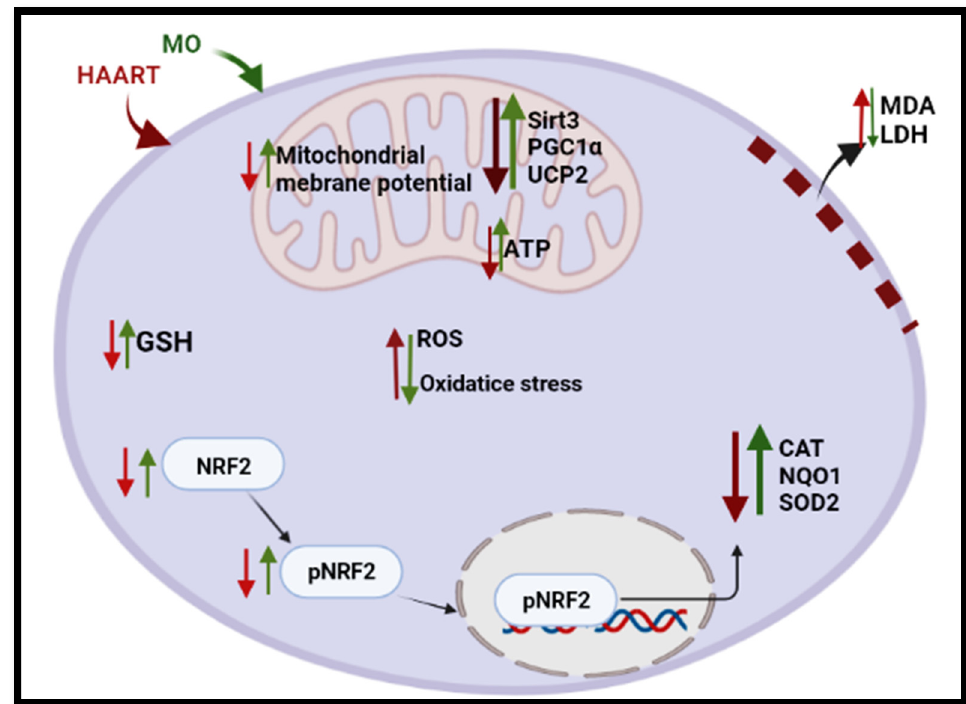
Figure 8. A brief overview of MO’s potential to ameliorate the long-term HAART-induced toxicity in HIV-positive individuals. HAART depolarises the mitochondrial membrane and reduces ATP. HAART increases ROS and reduces GSH and other antioxidants, therefore promoting oxidative stress. The addition of MO attenuates ARV toxicity by increasing the polarisation of the mitochon- dria and ATP synthesis. MO scavenges ROS and restores GSH levels. MO upregulates the NRF2 antioxidant pathway and further reduces oxidative stress. MO leaf extracts reduce MDA and LDH levels by reducing the peroxidation of lipids. Created in Biorender.com (access date: 14 June 2022).